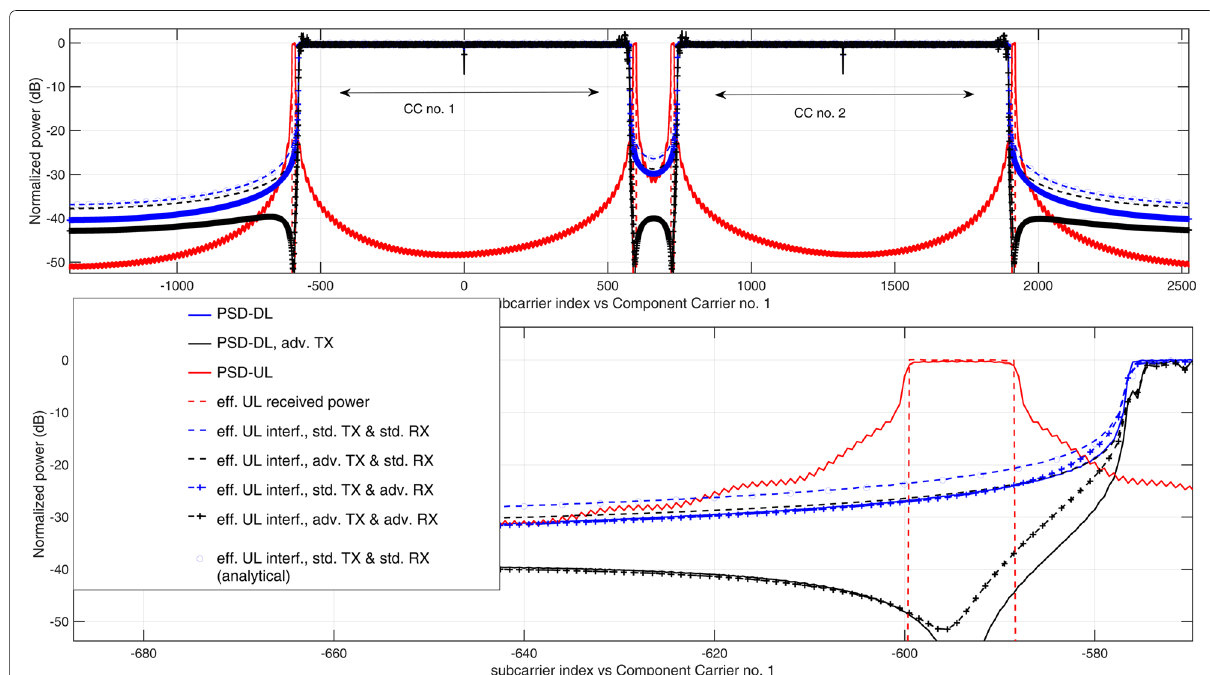
Fig. 6 Normalized PSDs of UL and DL transmitted signals, effective interference/useful signal power at cell B base station (receiver)—multichannel case. Only lower frequency edge is shown at the bottom figure [13]